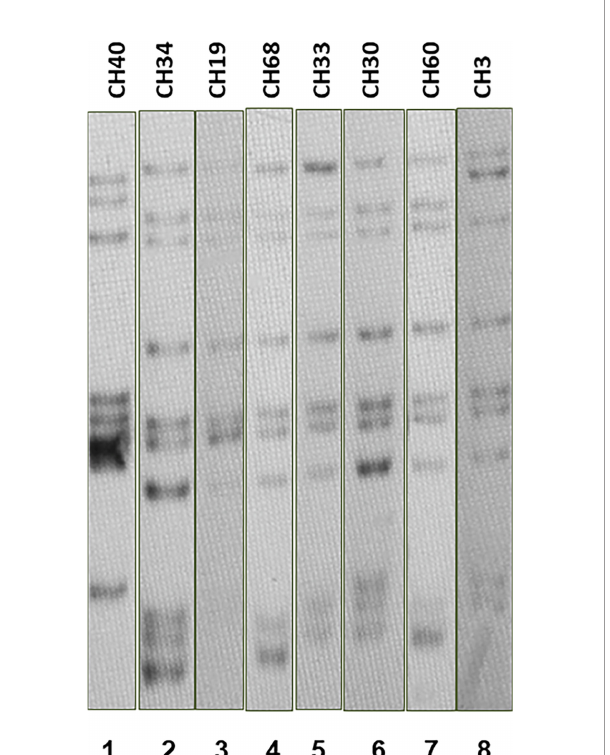
FIGURE 2 | IS 6110 RFLP patterns for MTB SIT53 isolates belonging to lineage 4.8 (CH19 to CH3). All 4.8 lineage isolates (lanes 3 to 8) presented the same IS 6110 pattern (except CH40), as well as CH34 (lane 2) which belongs to lineage 4.0.